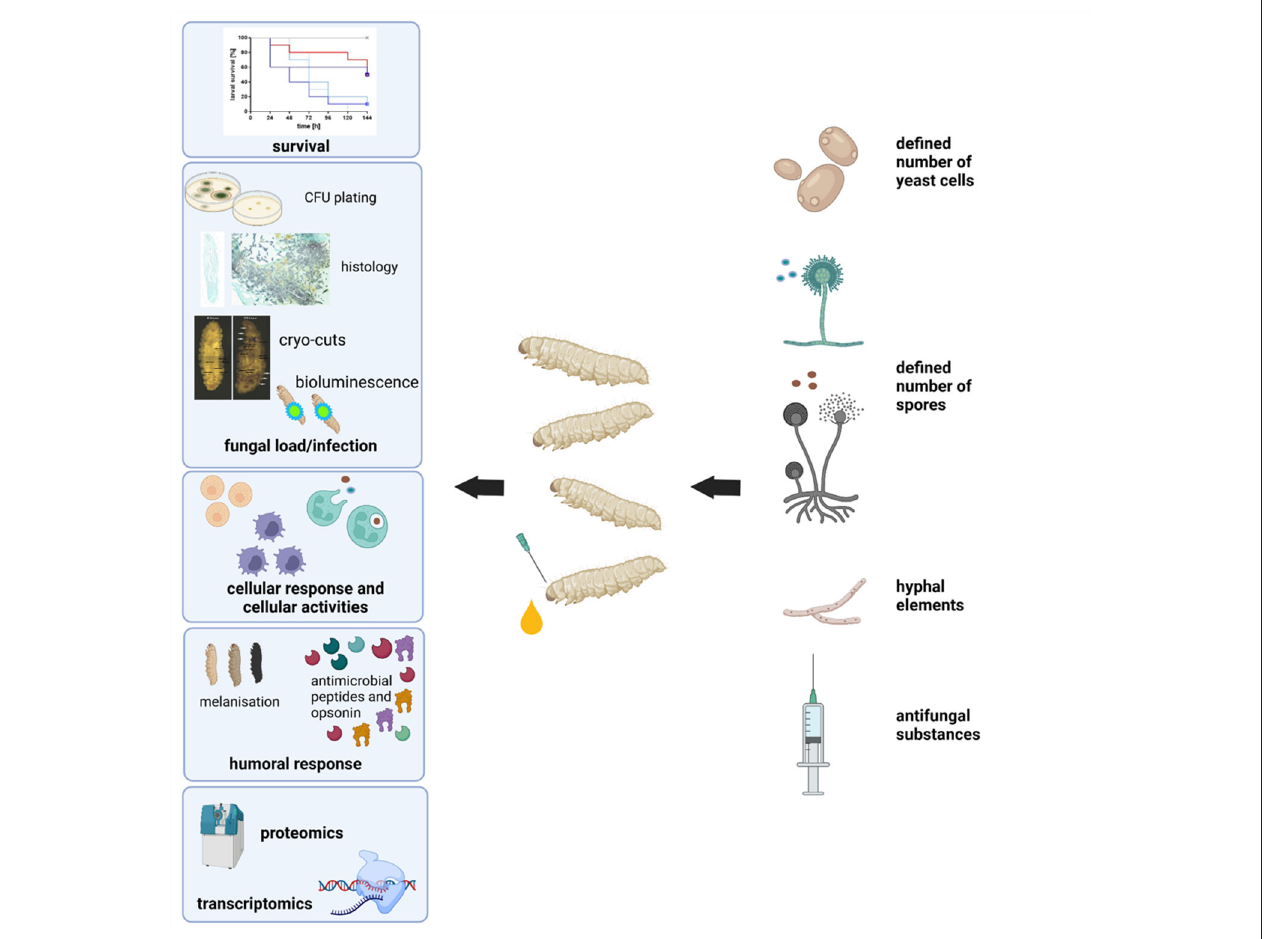
FIGURE 2 | Schematic overview of experimental end-points when using G. mellonella larvae as an infection